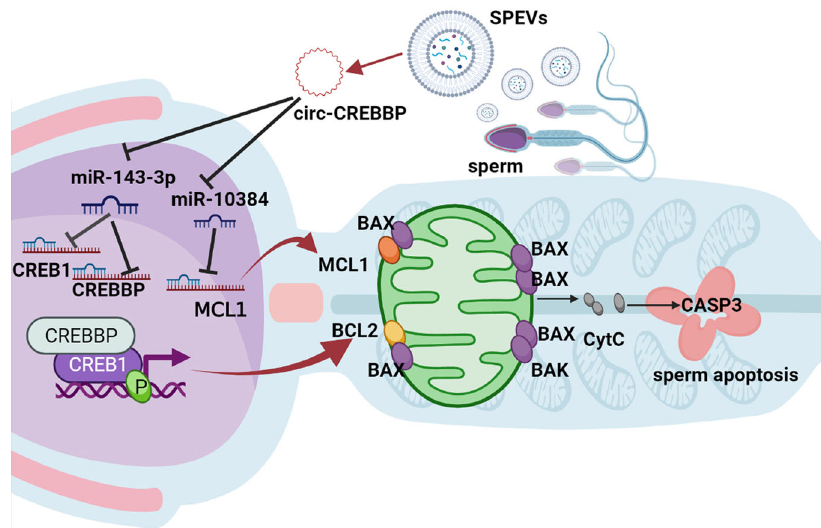
Fig. 8 Schematic diagram of pathways by which circ-CREBBP regulates motility and apoptosis of porcine sperm. The graphic was created with